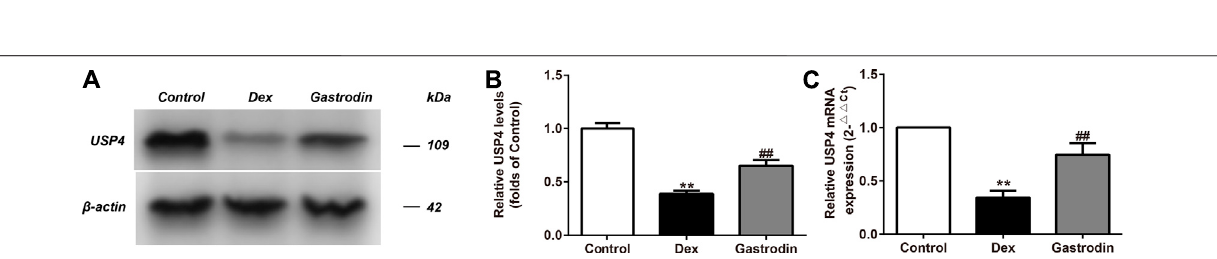
Frontiers in Pharmacology |